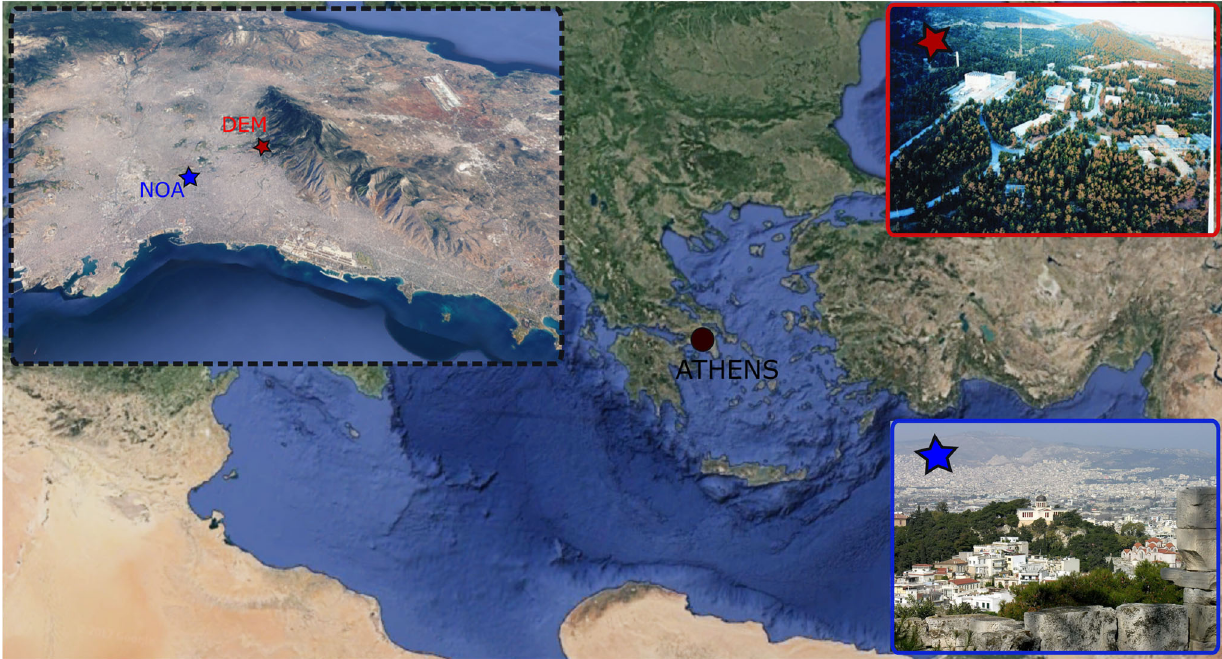
Figure 1. Regional map along with 3-D satellite map of the Athens Metropolitan area (black dashed rectangle), and photos of the NCSR Demokritos (DEM) campus in Agia Paraskevi (Athens suburban, red star), and of the National Observatory of Athens (NOA) at Thi- seio (Athens centre, blue